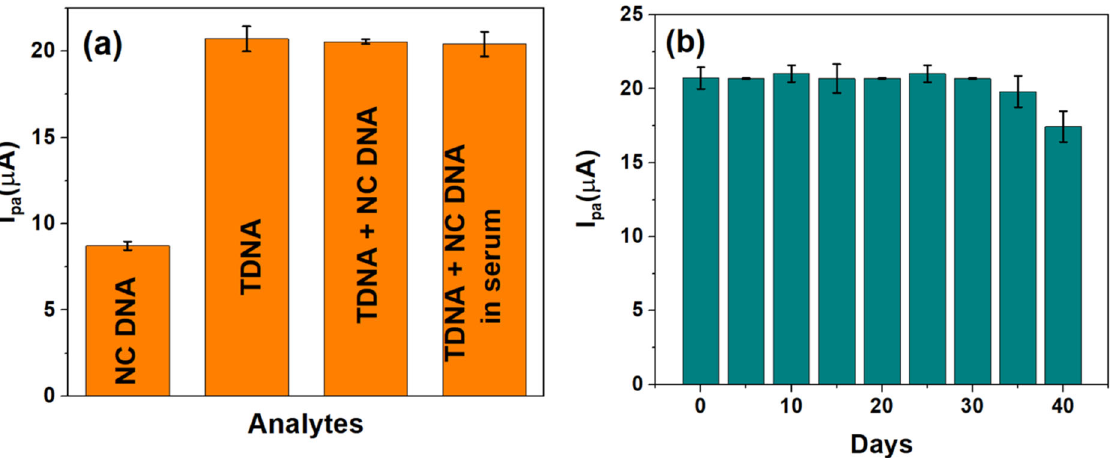
Figure 5. ( a ) Selectivity and real sample analysis and ( b ) shelf-life studies of the developed genosensor over a period of 1 month.